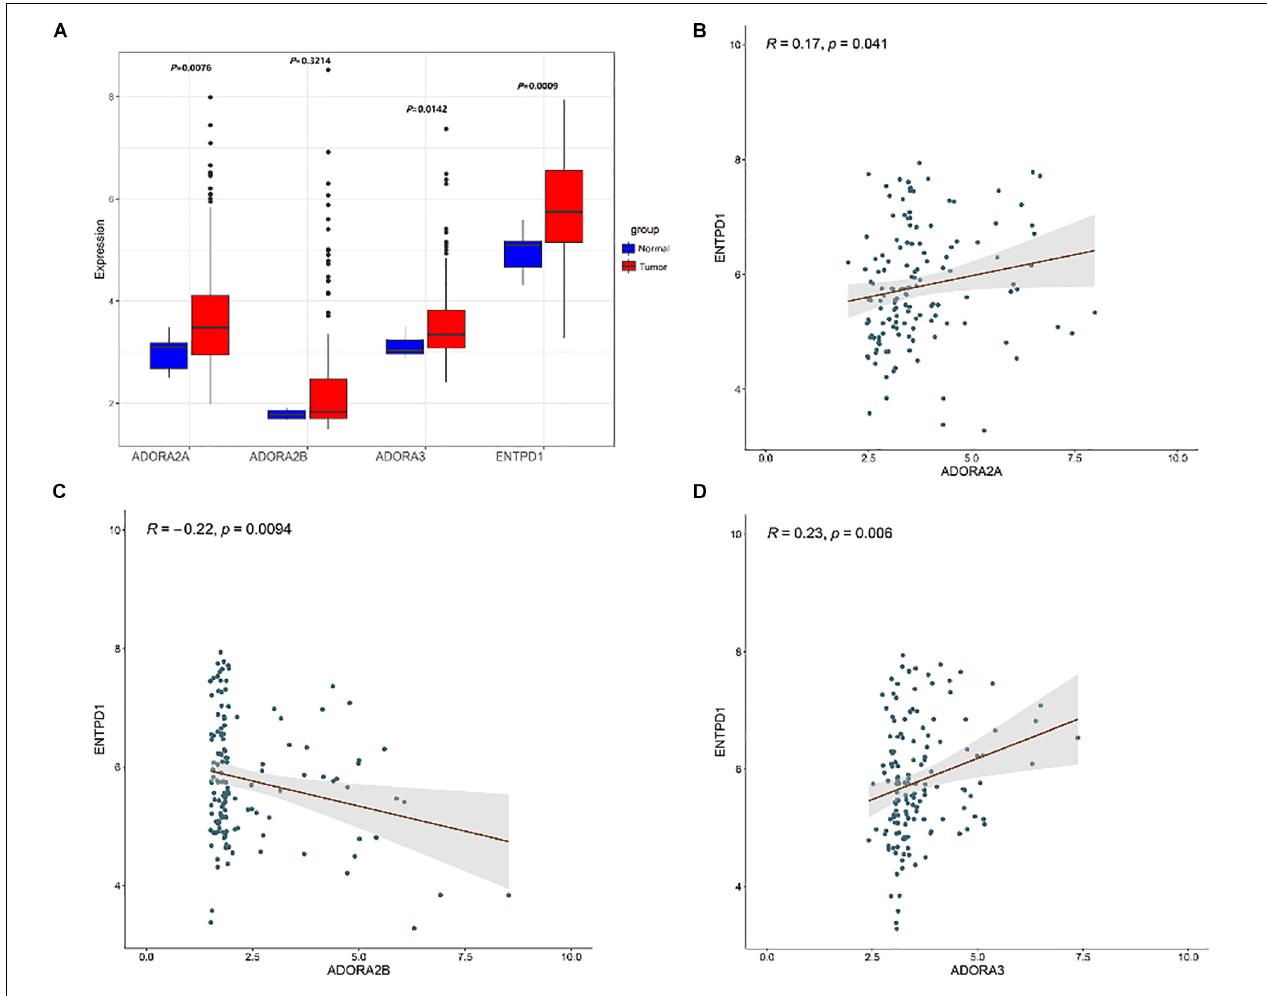
ethnicity ( Figure 2F , P = 0.2816), T classification ( Figure 2G , P = 0.5516), N classification ( Figure 2H , P = 0.1377), M classification ( Figure 2I , P = 0.5877), clinical stage ( Figure 2J , P = 0.6339), lymph node ( Figure 2K , P = 0.1999), and vital status ( Figure 2L , P =